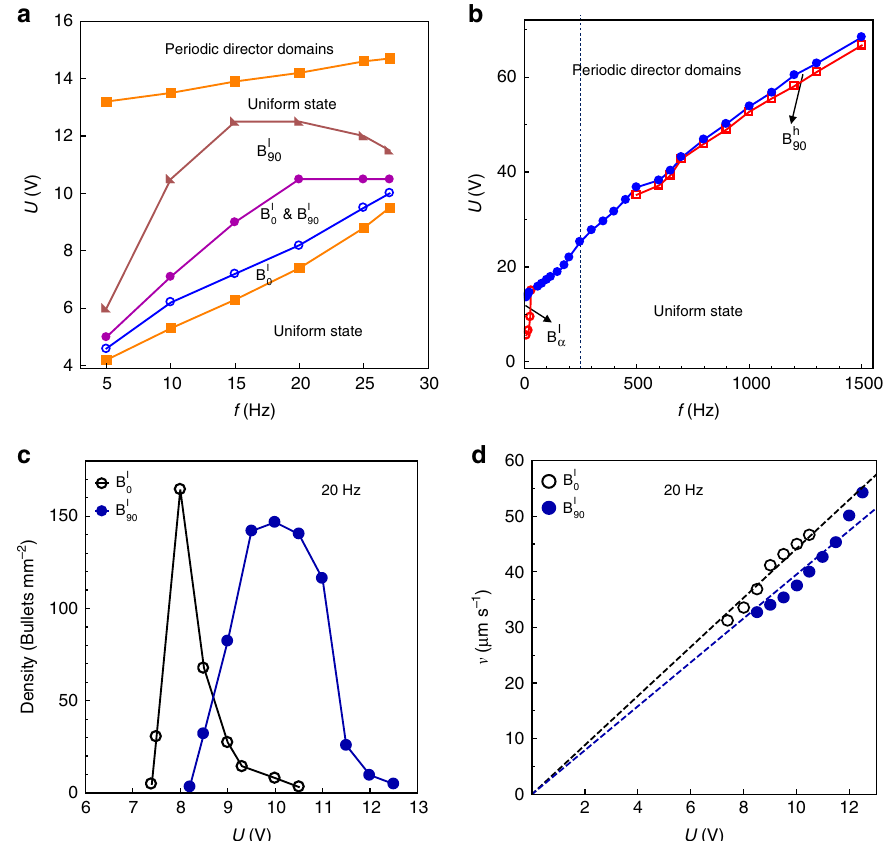
Fig. 4 Soliton properties as a function of the applied voltage. a Phase diagram of director bullets B l α at low frequencies. b Phase diagram of director bullets B l α and B h 90 in the broad range of frequencies explored for the same nematic cell. B h 90 are (3 + 1)D director bullets. c Densities and d velocities of B l 0 and B l 90 as a function of the applied voltage. All data correspond to 55